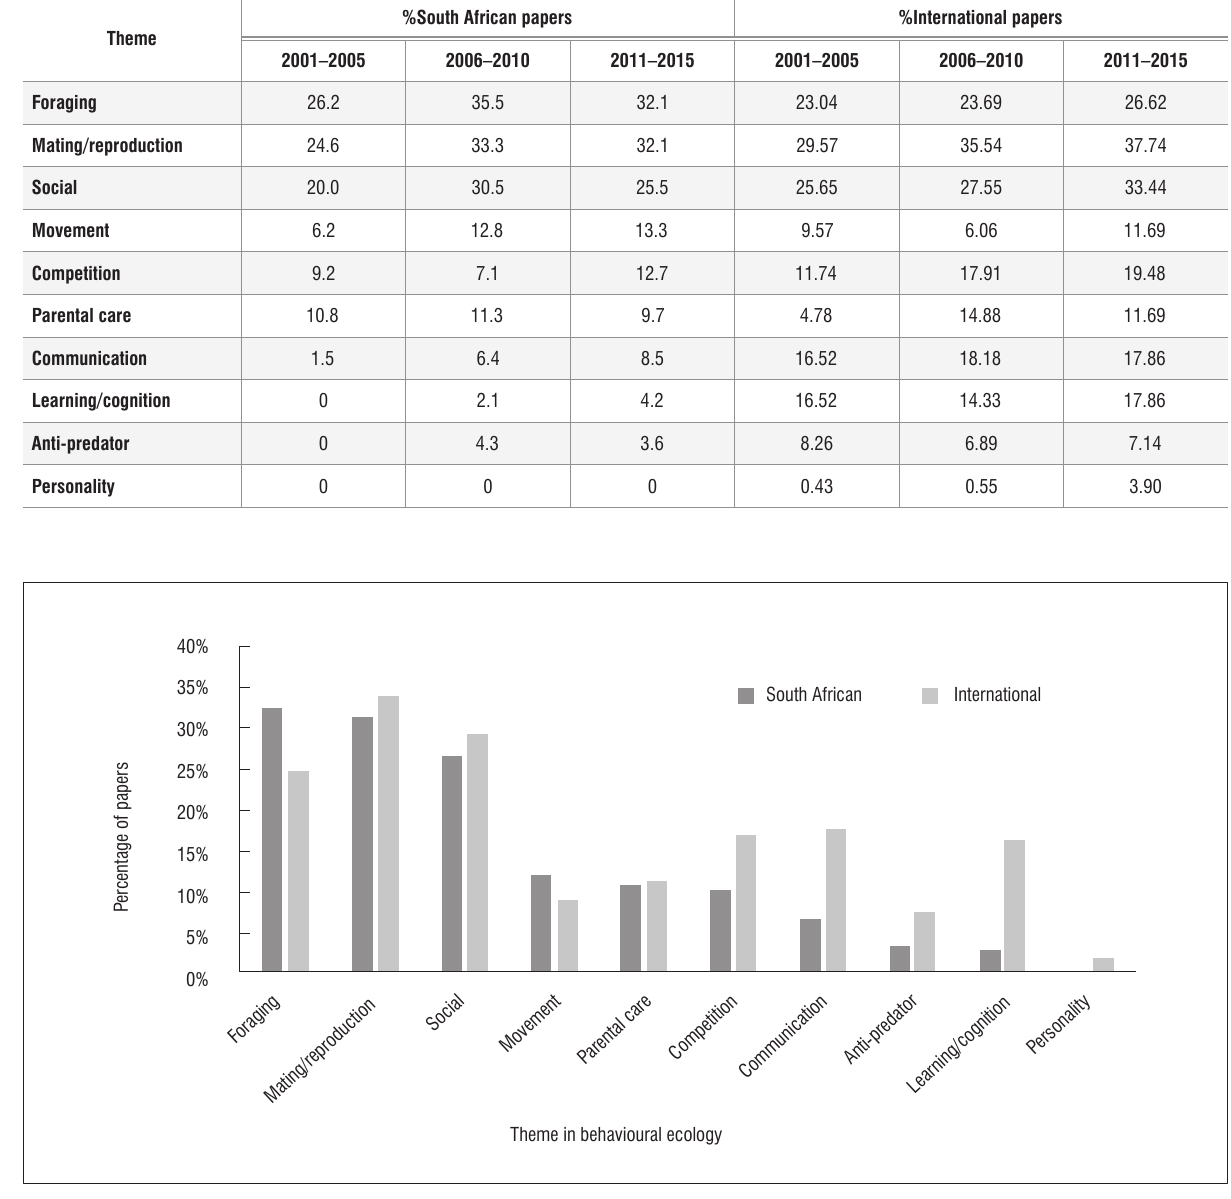
The percentage of articles and review papers examining 10 different themes within the discipline of behavioural ecology. South African authors’ outputs between 2001 and 2015 are contrasted with the papers produced by non-South African (international) researchers over the same